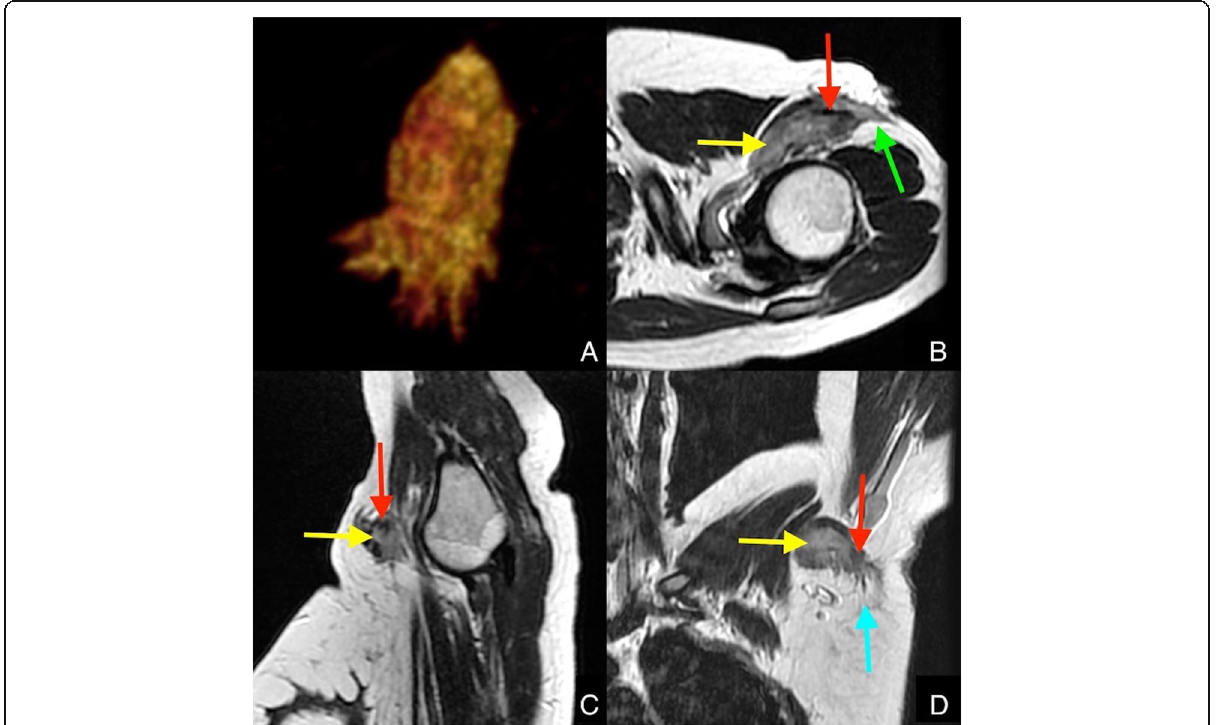
Fig. 2 MRI images of the left armpit. A Three-dimensional reconstruction with volume rendering of the lesion showing its ill-defined and infiltrative aspect. B Axial pre-contrast T2 showing a heterogeneous, irregular and poorly delimited lesion in the left axillary region, extending through the adipose planes forming the tail sign (green arrow). Hypersignal areas are noted (yellow arrow), as well as low signal bands (band signal — red arrow). C Sagittal pre-contrast T2. A yellow arrow highlights the area with the greatest signal, and a red arrow shows the hyposignal bands. D Coronal pre-contrast T2 representing once again the areas of high signal (yellow arrow) and low signal (red arrow), in addition to fine projections of the tumor to the adjacent fat planes (blue